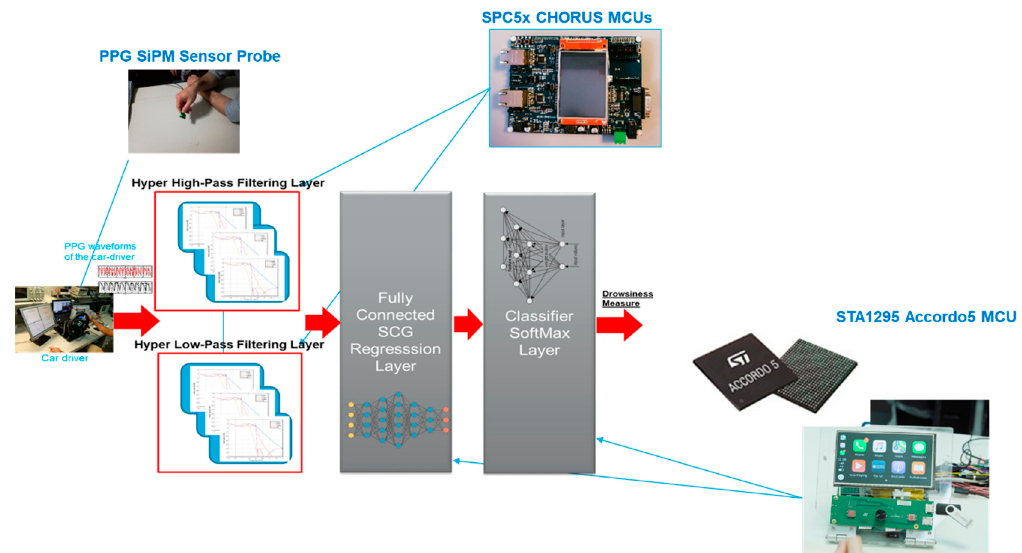
Figure 15. The overall embedded platform for the proposed pipeline.